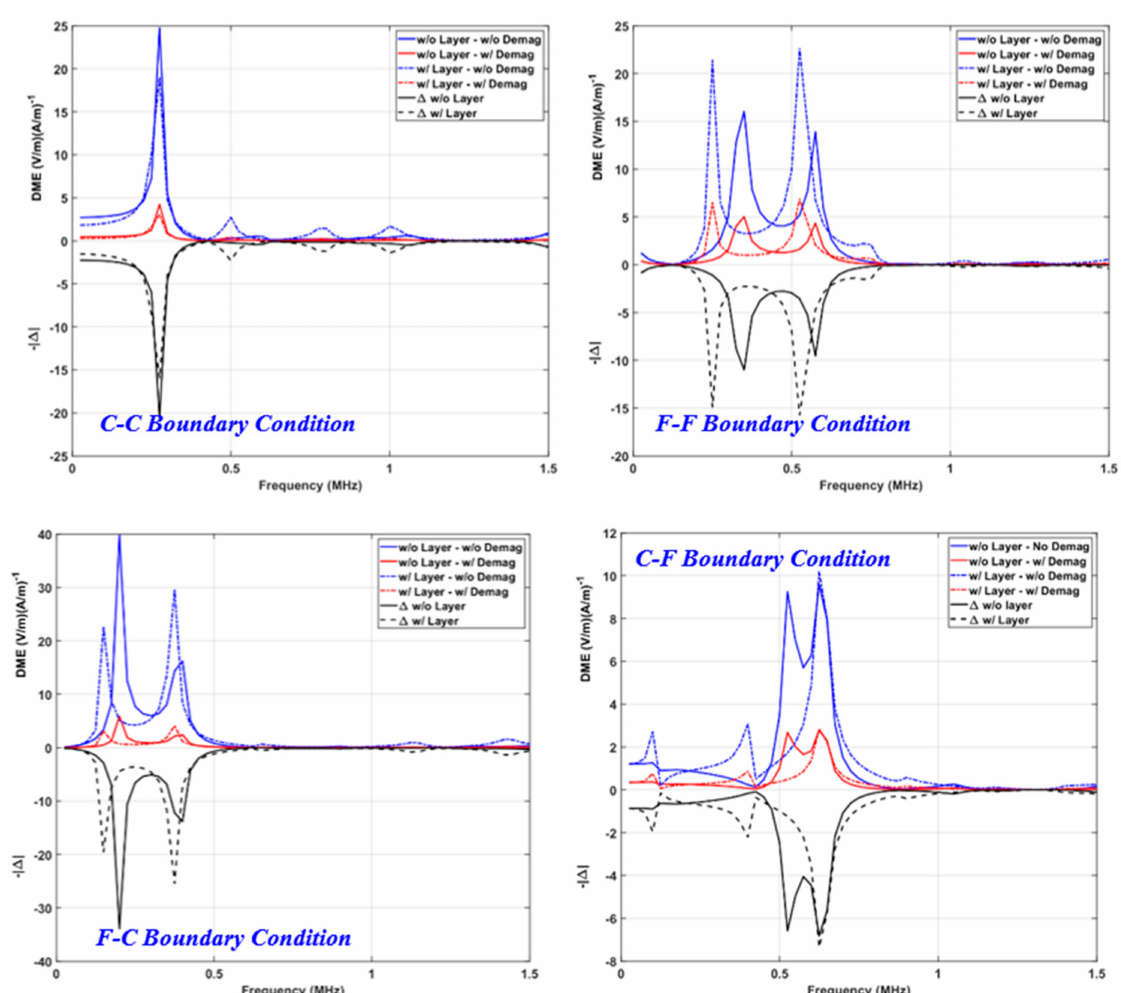
Figure 3. The frequency-dependent DME response of a concentric composite cylinder for four mechanical boundary conditions; at the bottom of each figure is the difference between the responses when the demagnetization effect was considered and